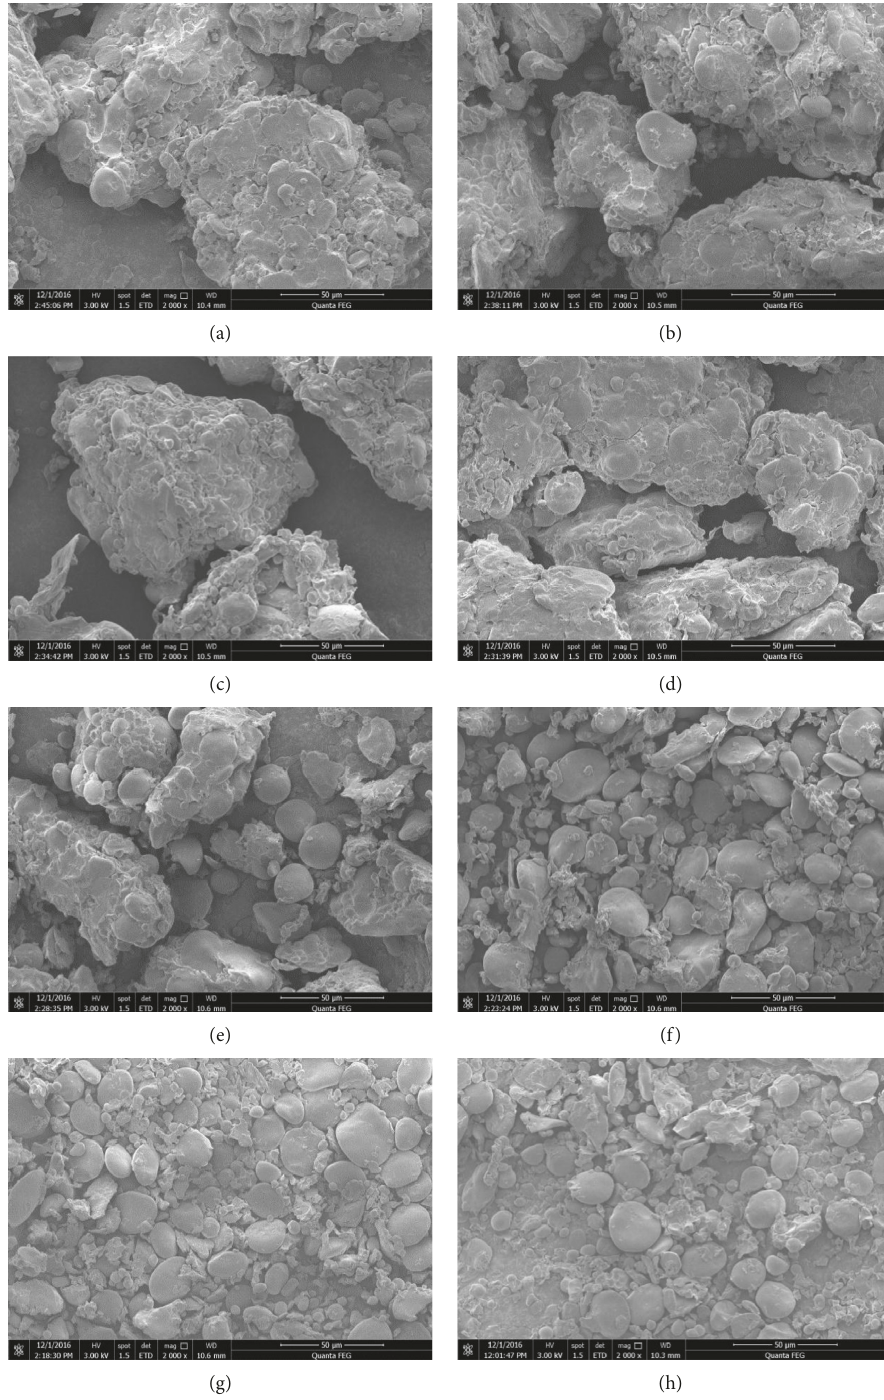
Figure 1: Scanning electron microscopy images of flour particles of different sizes: (a) #1; (b) #2; (c) #3; (d) #4; (e) #5; (f) #6; (g) #7, and (h)